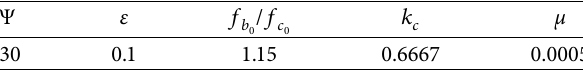
Figure 23: Model of the rebar net. Table 11: Parameter settings in concrete CDP model.